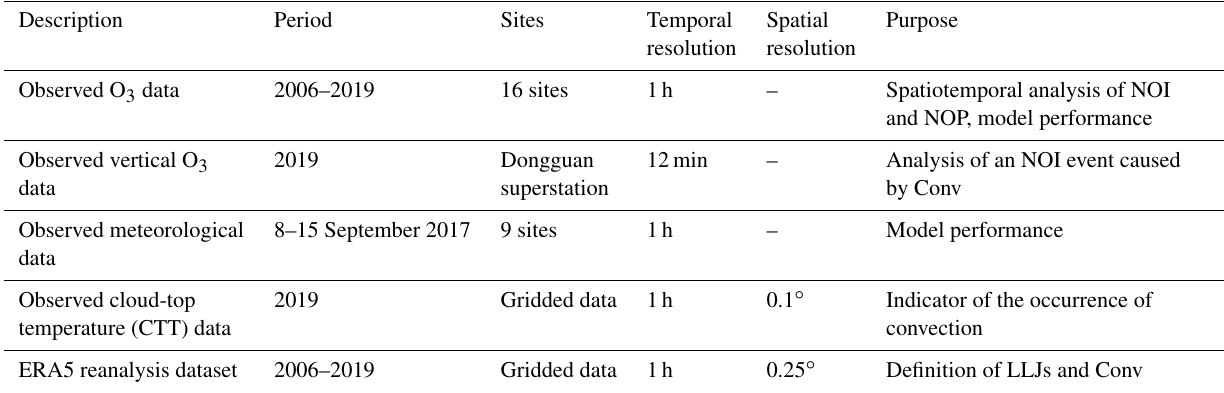
Table 1. Summary of the dataset used in this